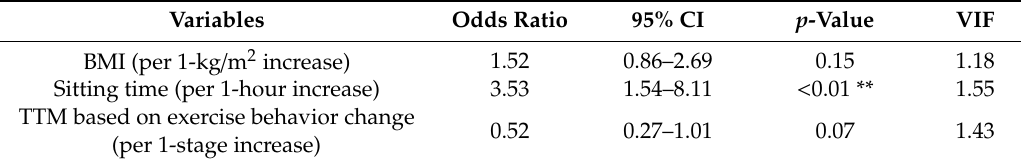
Table 4. Binomial logistic regression analysis for HbA1c (age-gender adjusted